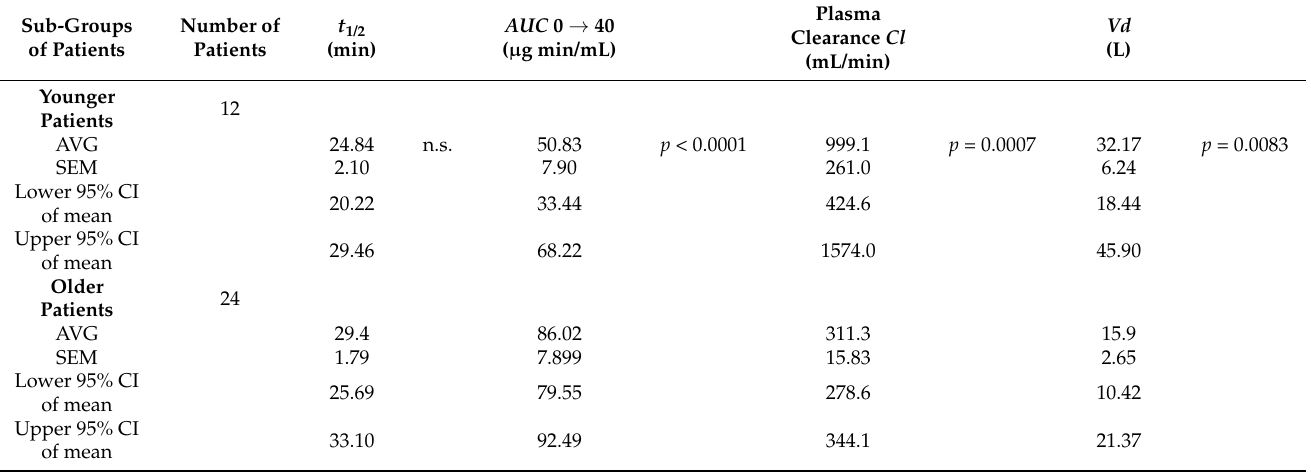
Table 2. Comparison of pharmacokinetic parameters, obtained in 40 min post-bleomycin intravenous injection, of patients younger and older than 65 years treated by electrochemotherapy with 15,000 IU/m 2 bleomycin. Sub-Groups of